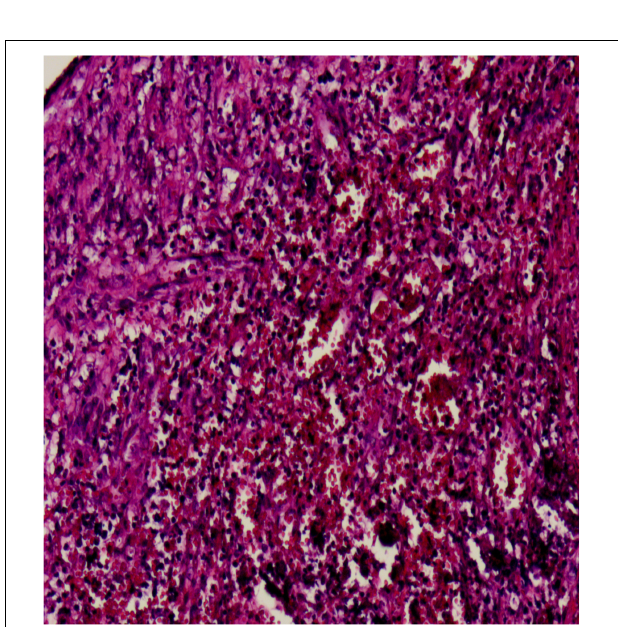
FIGURE 5 | Microscopic image of the lesion (hematoxylin and eosin staining, magnification × 200). Showing the tumor wall was composed of mixed thrombus with